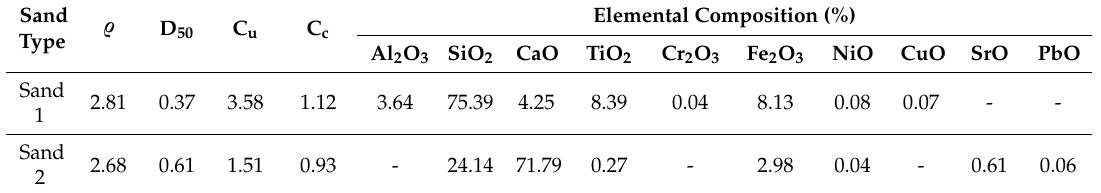
Table 1. Characteristics of natural beach sand used in the current study and their elemental